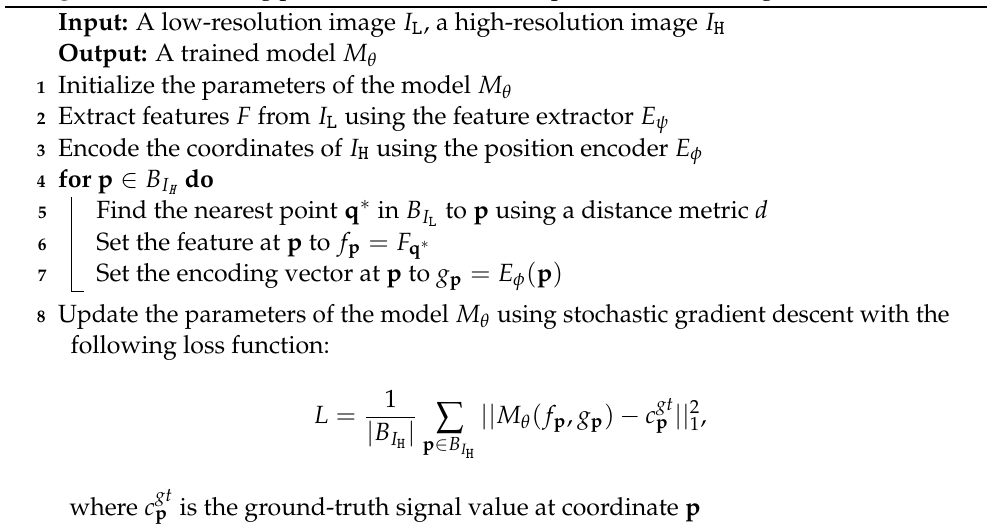
Algorithm 1: Training process of continuous super-resolution using